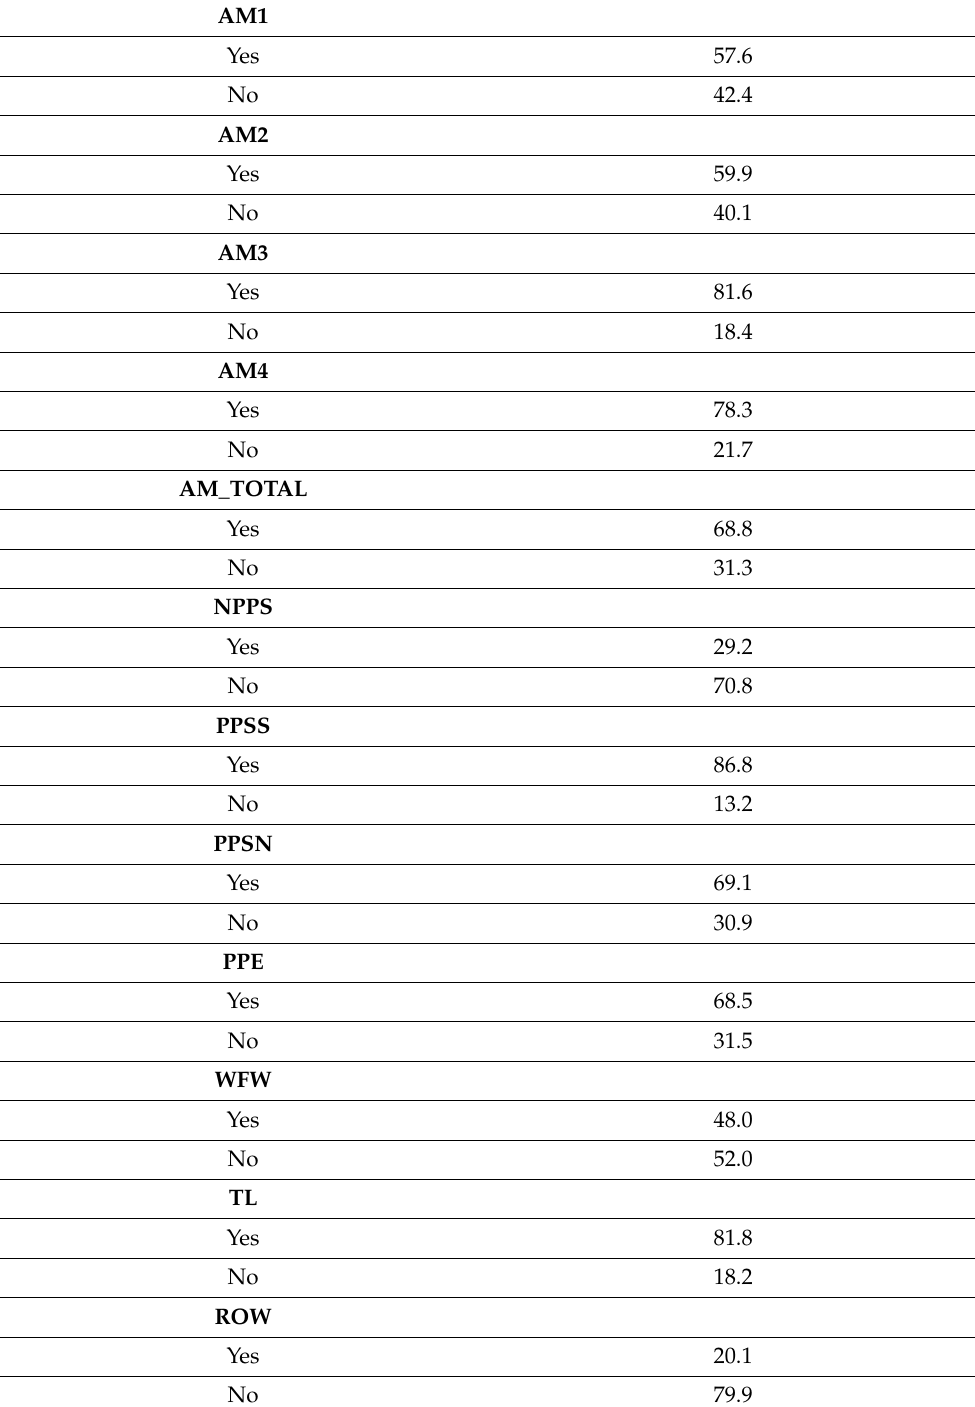
Table 3. Descriptive